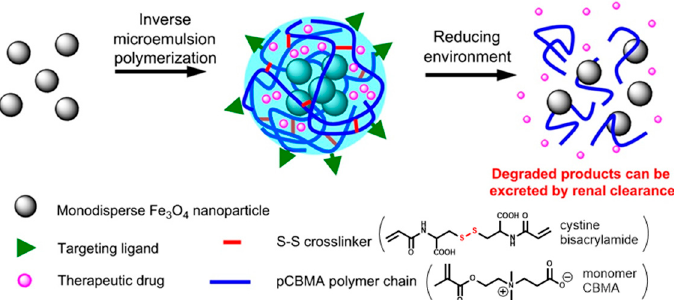
Figure 13. Schematic passages for the preparation of zwitterionic hybrid nanogel. Reprinted from Reference [83], Copyright (2011), with permission from Elsevier.